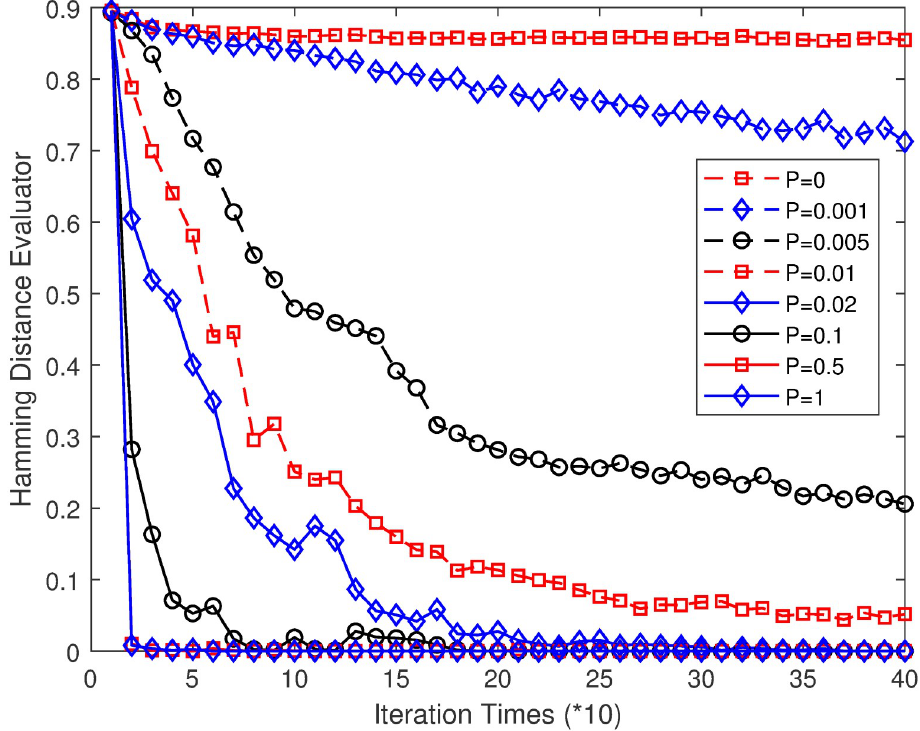
Fig 8. HDE curves over the iteration times for several values of P